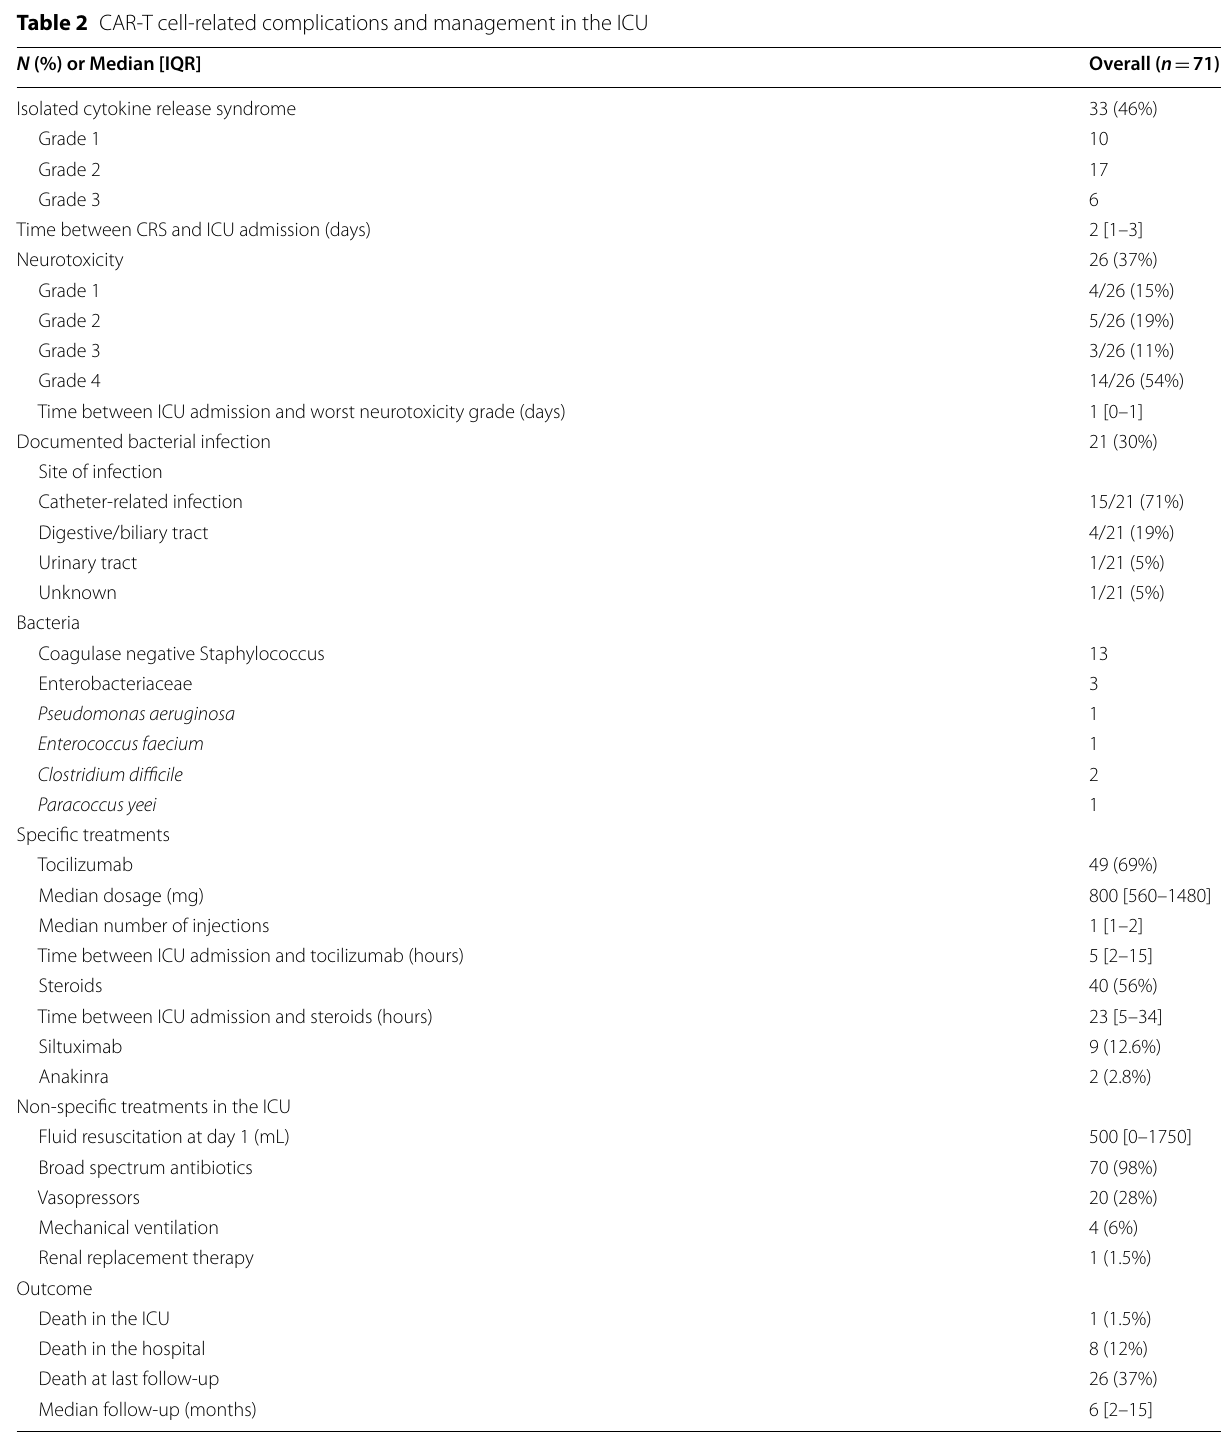
CRS cytokine release syndrome, ICU intensive care